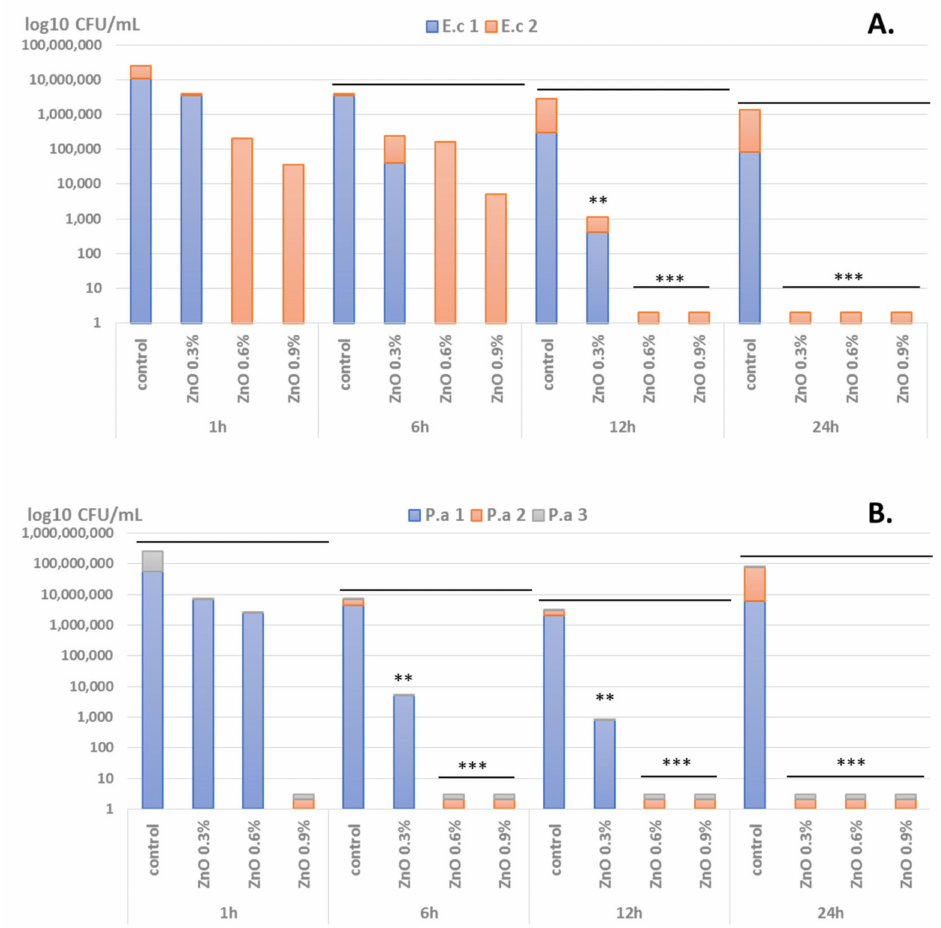
Figure 6. Graphical representation of log10 CFU/mL values obtained for the Gram-negative tested microbial strains (2 E. coli (E.c.) = ( A ) and 3 P. aeruginosa (P.a.) isolates = ( B )), expressing viability of bacteria incubated as 0.5 McFarland suspensions in PBS on the ZnO NPs-coated wound dressings for 1 h, 6 h, 12 h, and 24 h (** p < 0.001; *** p < 0.0001 by comparing viability on control coatings with ZnO-coated dressings).